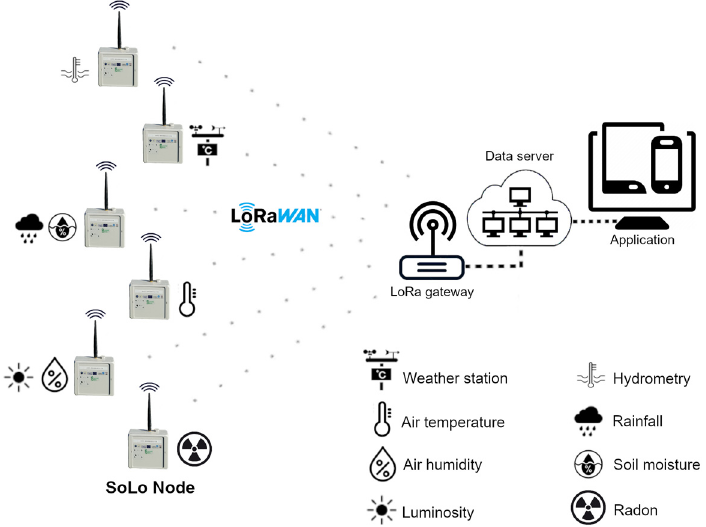
Figure 2. Private communication network based on a private LoRaWAN network to transmit data from the sensors to scientists.